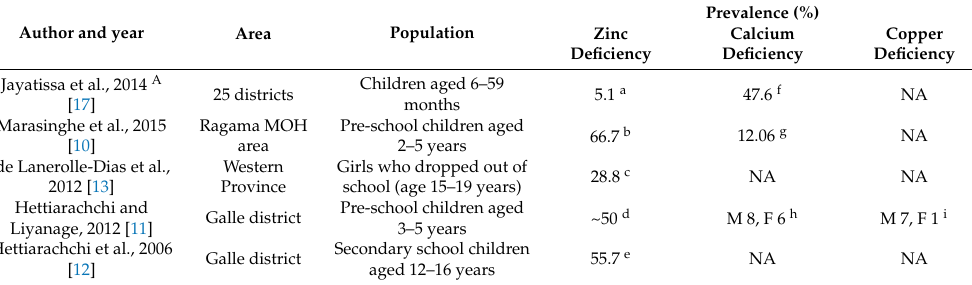
Table 7. Prevalence of zinc, calcium and copper deficiencies in Sri